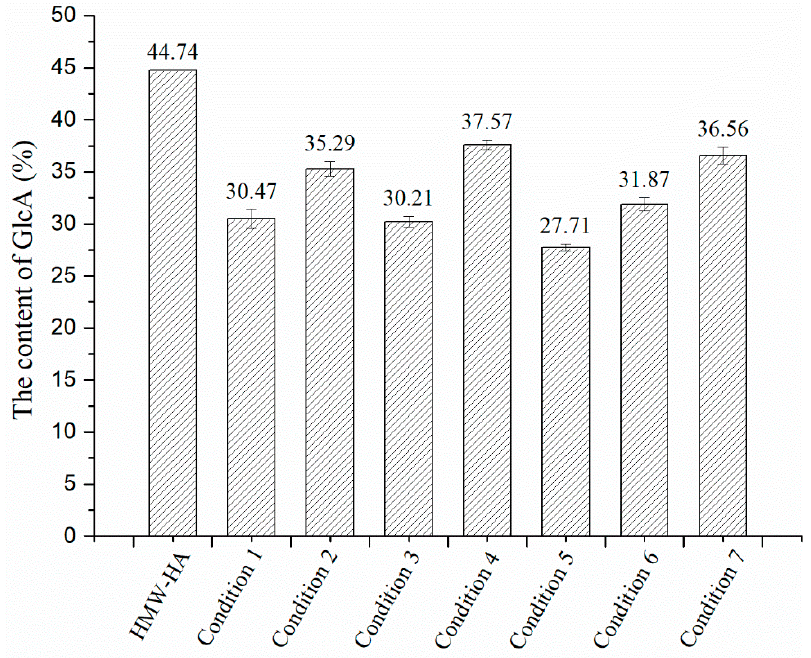
Figure 2. Content of glucuronic acid in LMW-HA degraded under each of seven conditions.